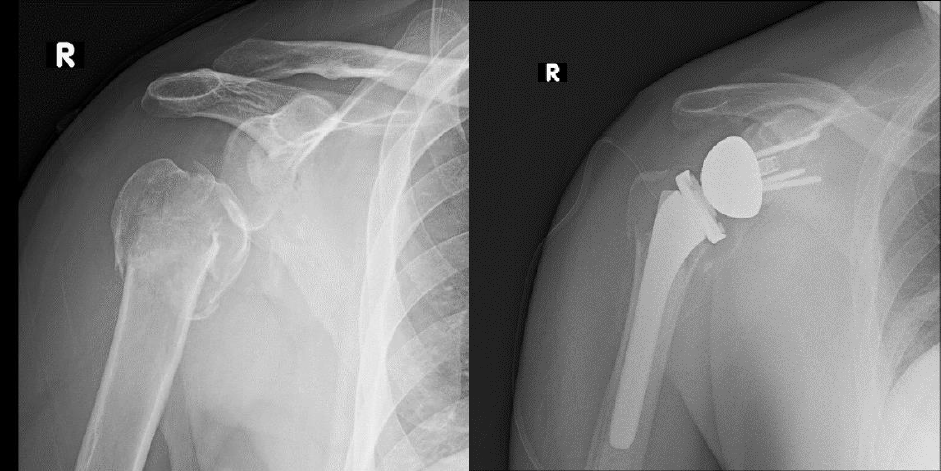
Figure 1. Preoperative and postoperative radiographs of Reverse Total Shoulder Arthroplasty (RTSA) with tuberosity reconstruction for a displaced, comminuted 4-part impacted proximal humerus fracture (PHF). R — radiographic marker for the right side Table 1. Surgical Indications.